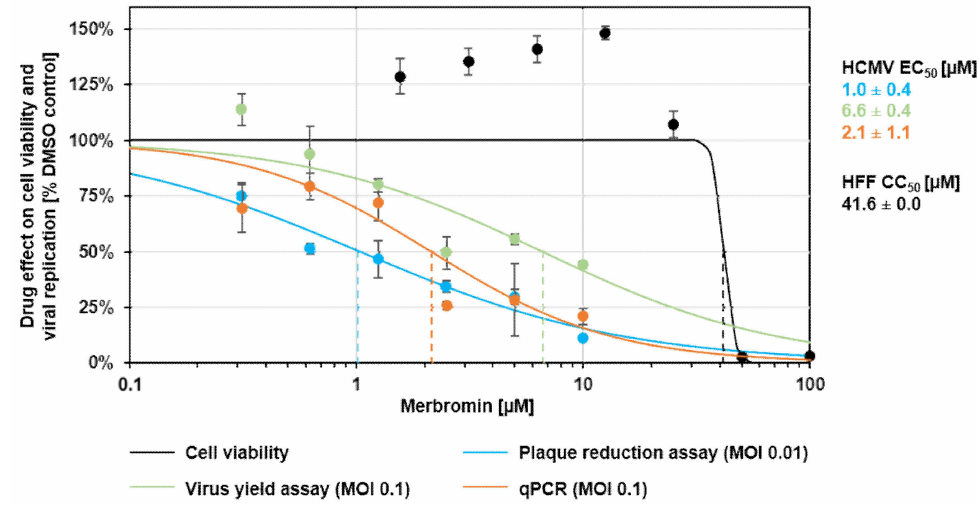
Figure 4. Anti-HCMV activity and lack of cytotoxicity (black curve) of merbromin in the plaque reduction assay (blue curve), virus yield assay (green curve), and genome-specific qPCR assay (orange curve). Error bars present standard deviations calculated from three or four different